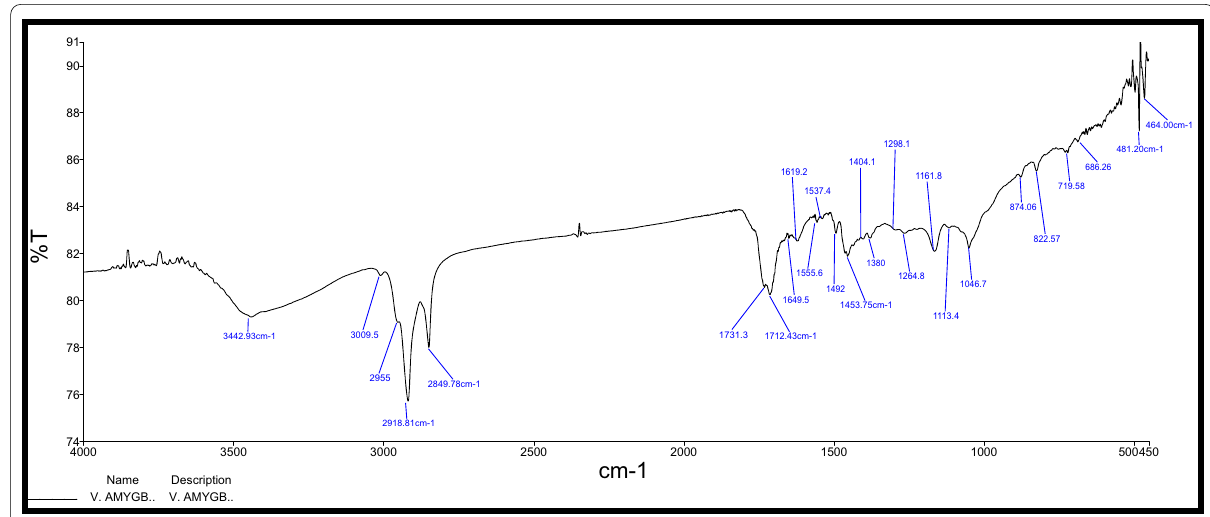
Fig. 2 FT-IR spectrum of V. amygdalina leaf chloroform extract showing the various absorption peak frequencies